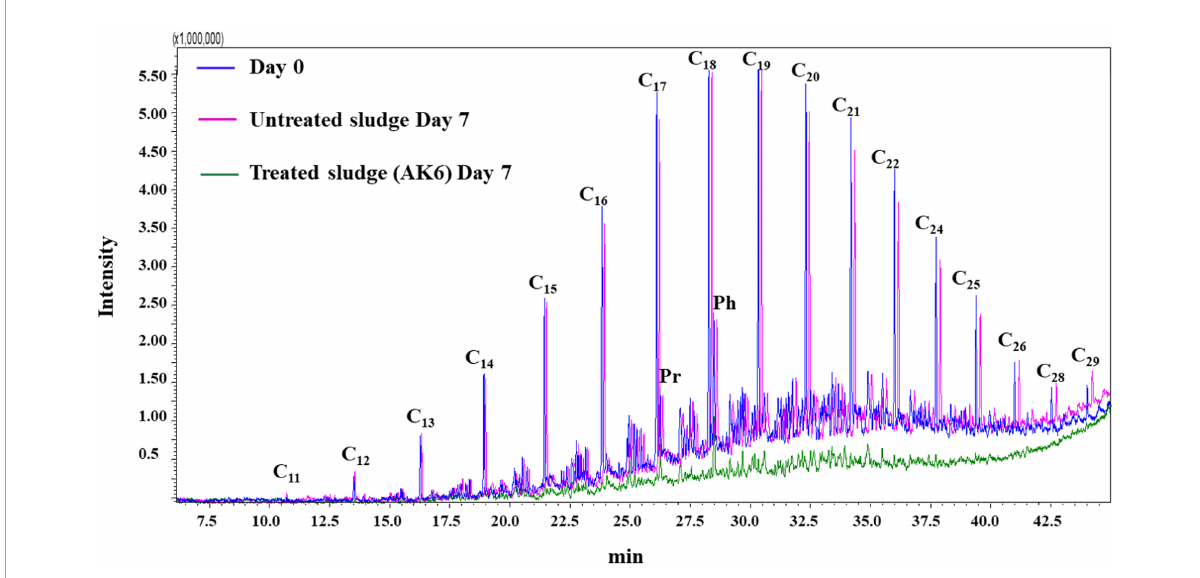
FIGURE1 Total ion chromatograms showing biodegradation of oily sludge hydrocarbons (extracted in dichloromethane) by the mixed culture AK6. The batch cultures contained oily sludge (5%, w/v) as the sole carbon and sulfur source and were incubated for 7 days at 40 ◦ C under shaking at 180 rpm. (Pr): pristane; (Ph):